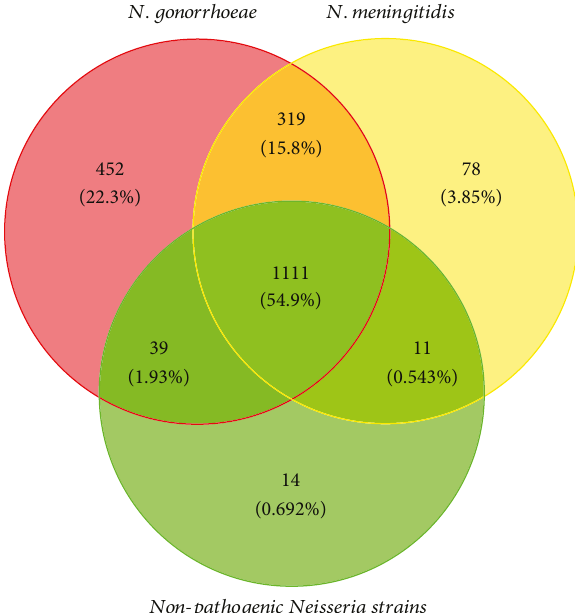
Figure 5: Venn diagram showing the distribution of shared gene families among NMS, NGS, and NPNS. Red, yellow, and green circles represent core genome of N. gonorrhoeae , N. meningitides , and nonpathogenic Neisseria strains, respectively. Their intersections represent the gene families they